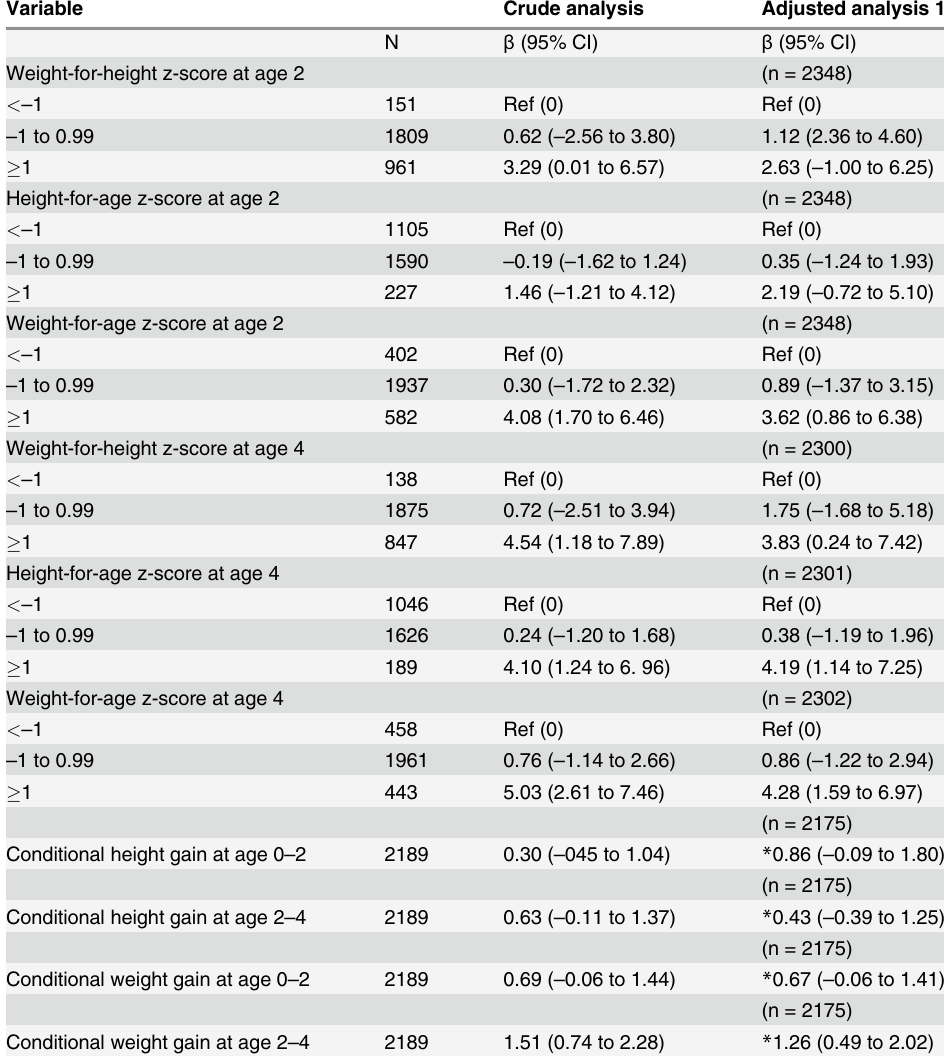
Table 3. Crude and adjusted analyses of the association of anthropometric measures of children and accelerated growth during infancy with carotid intima-media thickness in the cohort participants at the follow-up in